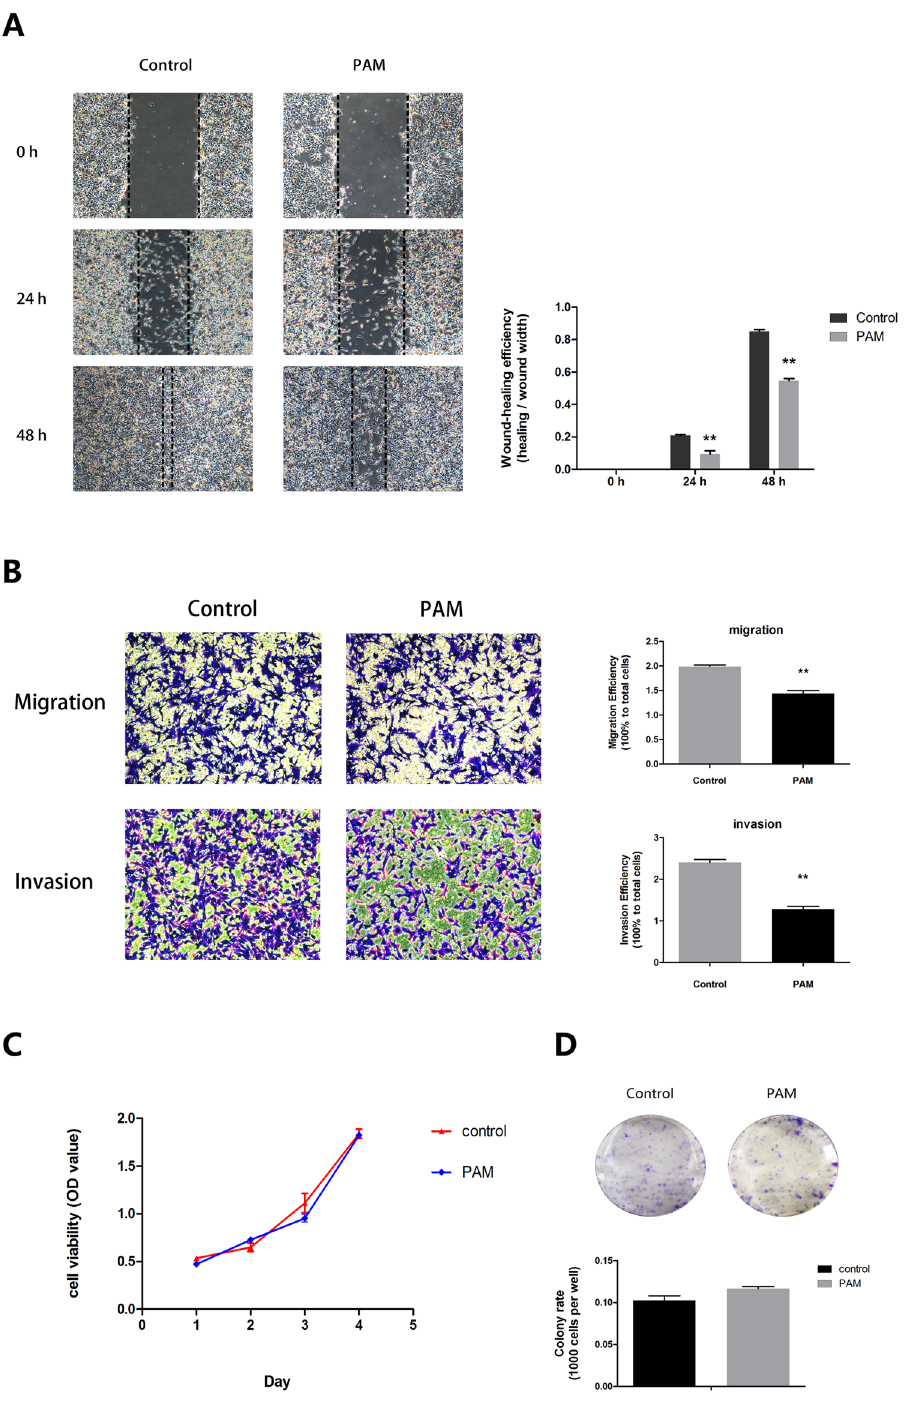
Figure 2. Plasma-activated medium (PAM) suppresses the migration and invasion abilities of ES2 cells. ( A ) Wound-healing assay at 0, 24 and 48 h after PAM treatment. ( B ) Transwell migration and invasion assay. Both migration and invasion abilities are calculated in comparison with the total seeded cells. ( C ) Proliferation assay for a total of 4 days. On each day, the Aqueous One Solution Cell Proliferation Assay reagent (Promega) is added for indication of cell number. ( D ) Colony-formation assay. Number of colonies was counted and compared to the total seeded cells. Three representative fields of cells in each group were captured and calculated, while one was selected for presentation in this study. Data are presented as mean ± SD. Three independent experiments with at least three replicates are performed. Statistics are shown as ** P <